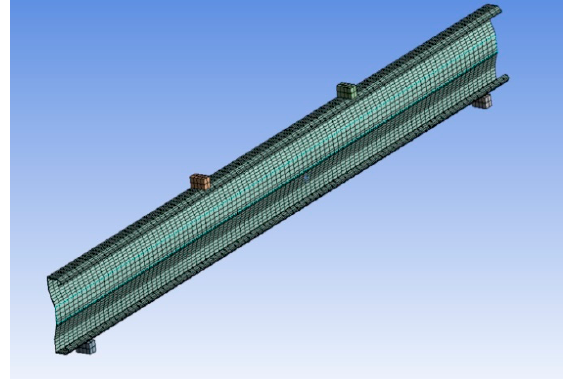
Figure 1. Meshing. Figure 1. Meshing.